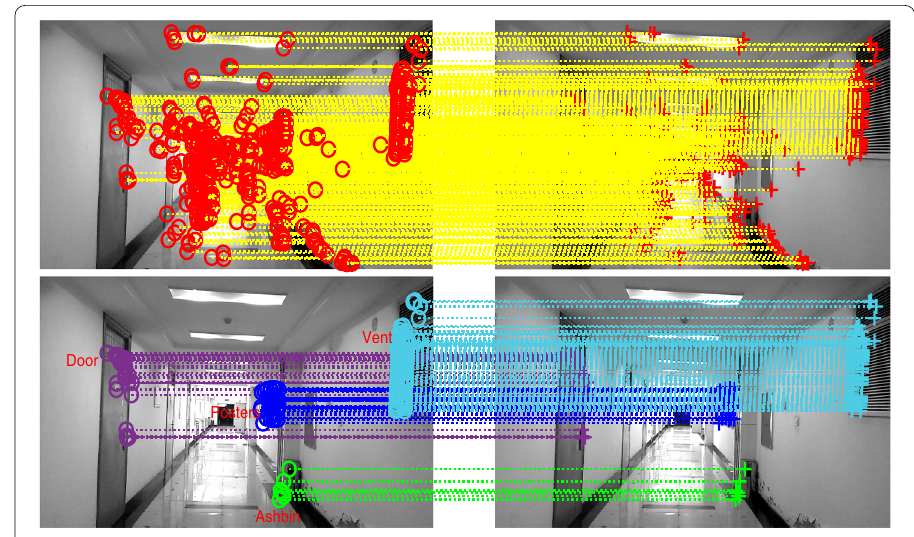
Fig. 4 Matching results by common SURF vs semantic